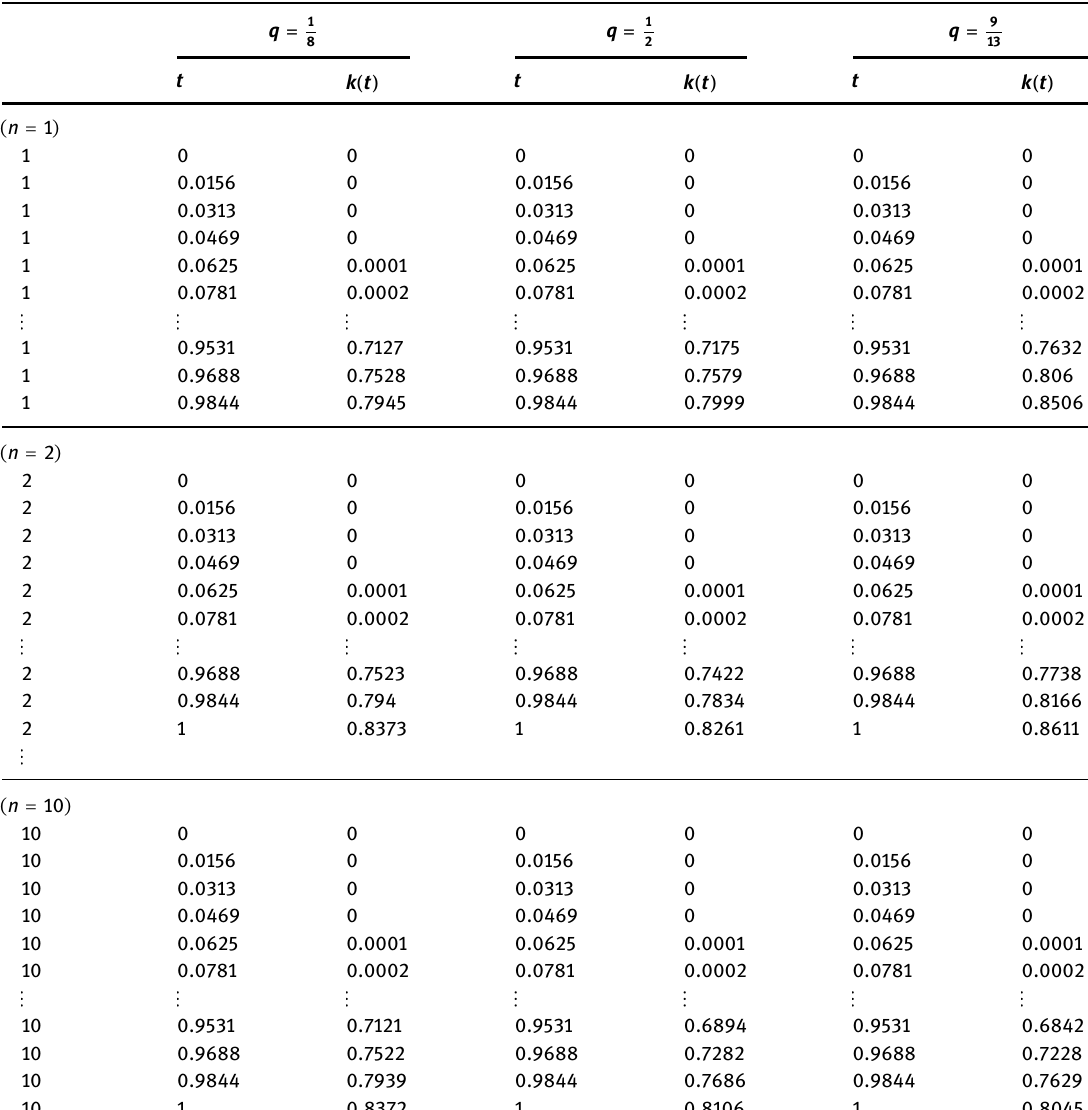
Table 8: Some numerical results of ( ) k t in Example 4.2 for ∈ t J